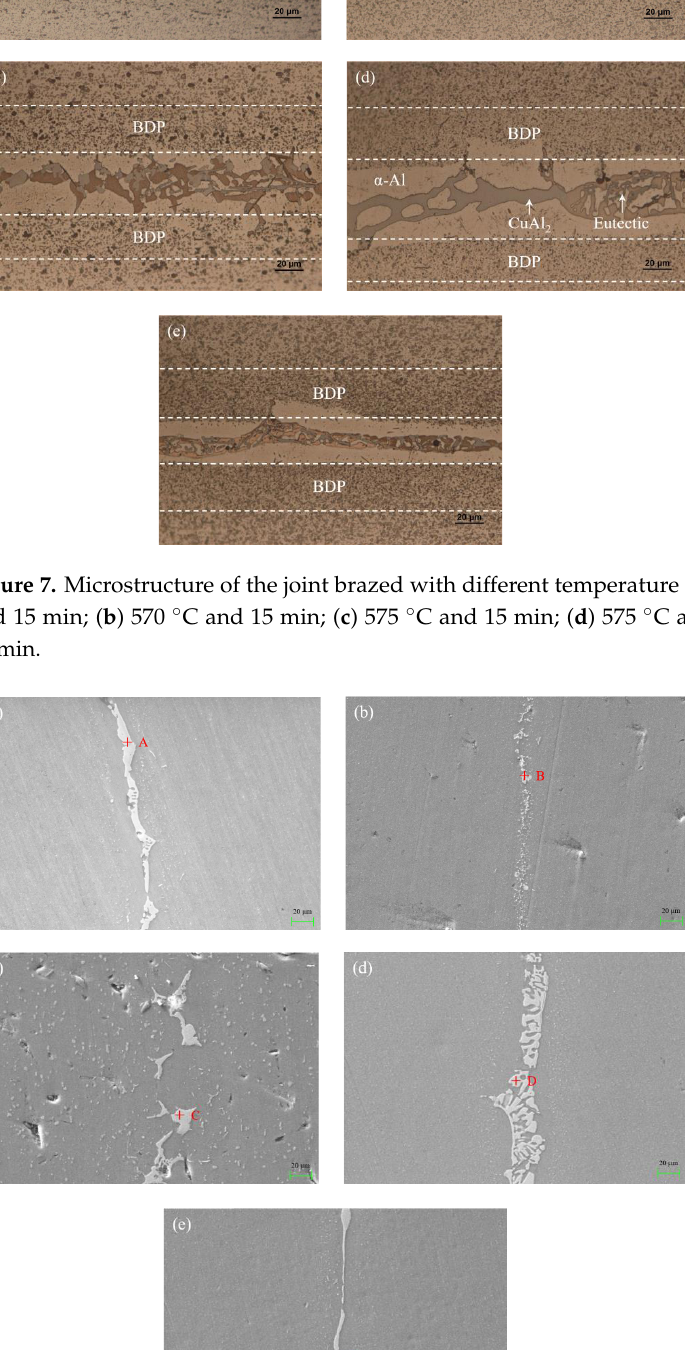
Figure 7. Microstructure of the joint brazed with different temperature and dwell time: ( a ) 565 °C and 15 min; ( b ) 570 °C and 15 min; ( c ) 575 °C and 15 min; ( d ) 575 °C and 20 min; ( e ) 575 °C and 25 min.